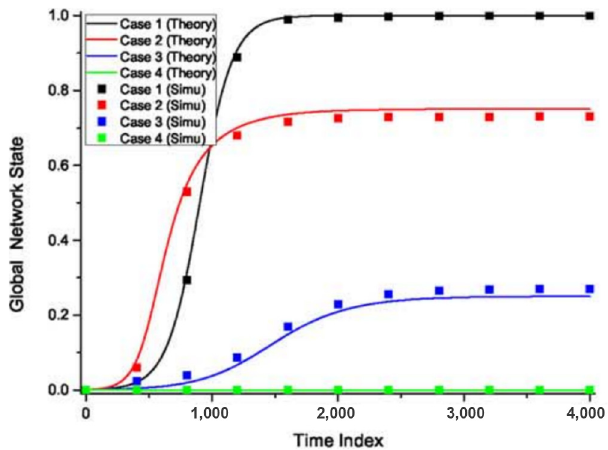
Figure 4. Simulation results for Erdo † s-Rényi random network which is a homogeneous non- uniform degree